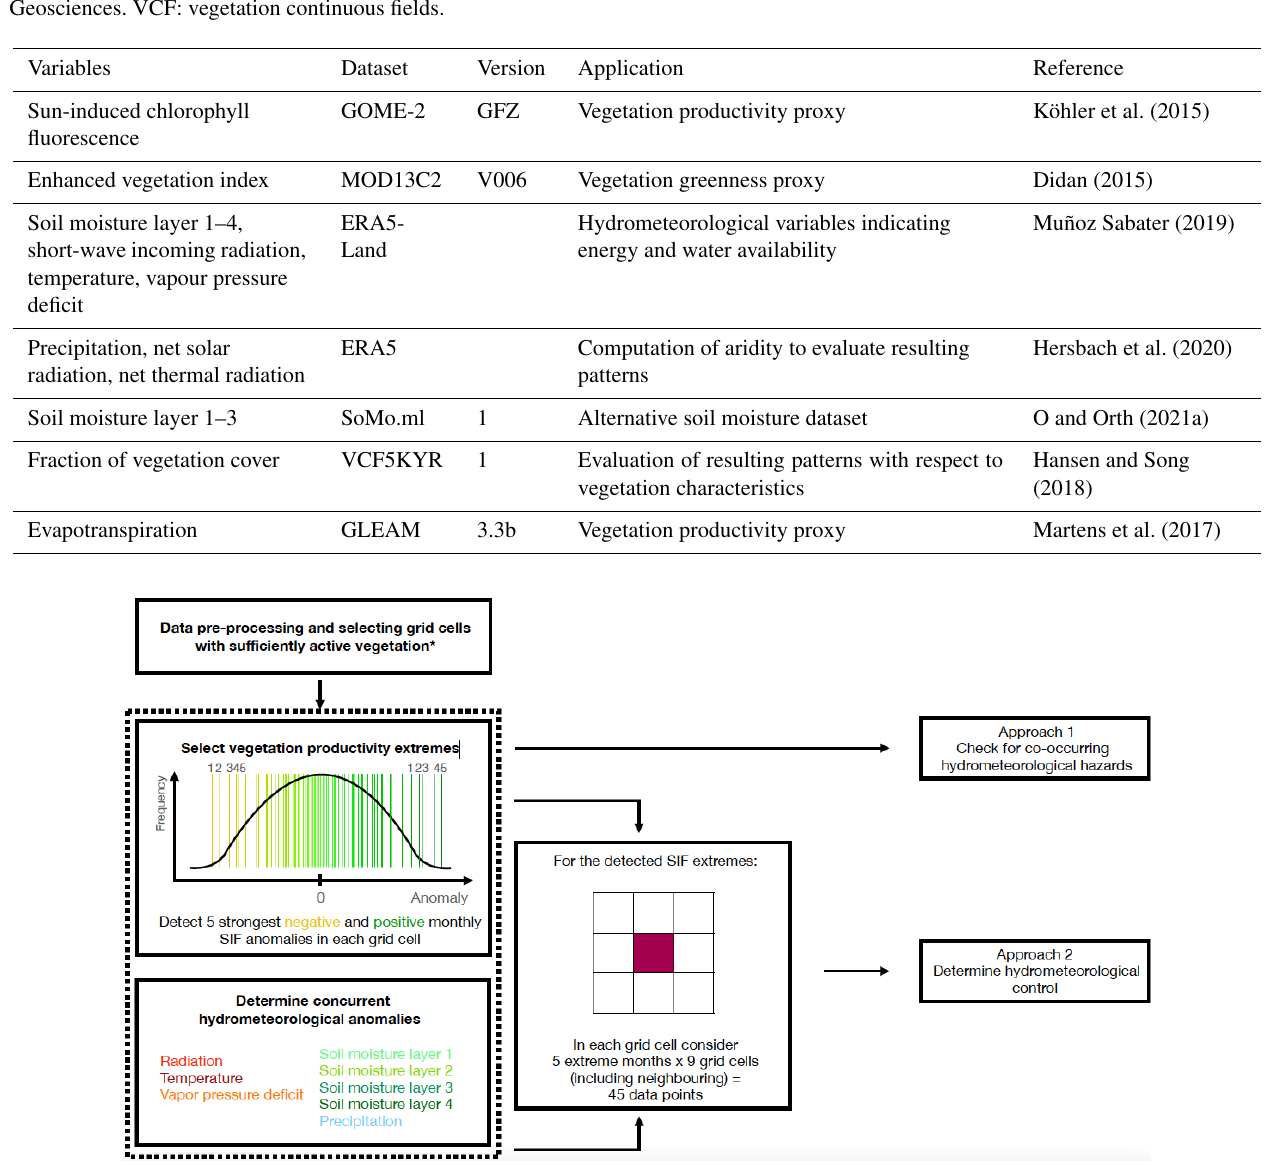
Figure 1. Schematic representation of our methodological approach. ∗ Filtering for sufficiently active vegetation is explained in Sect. 2.